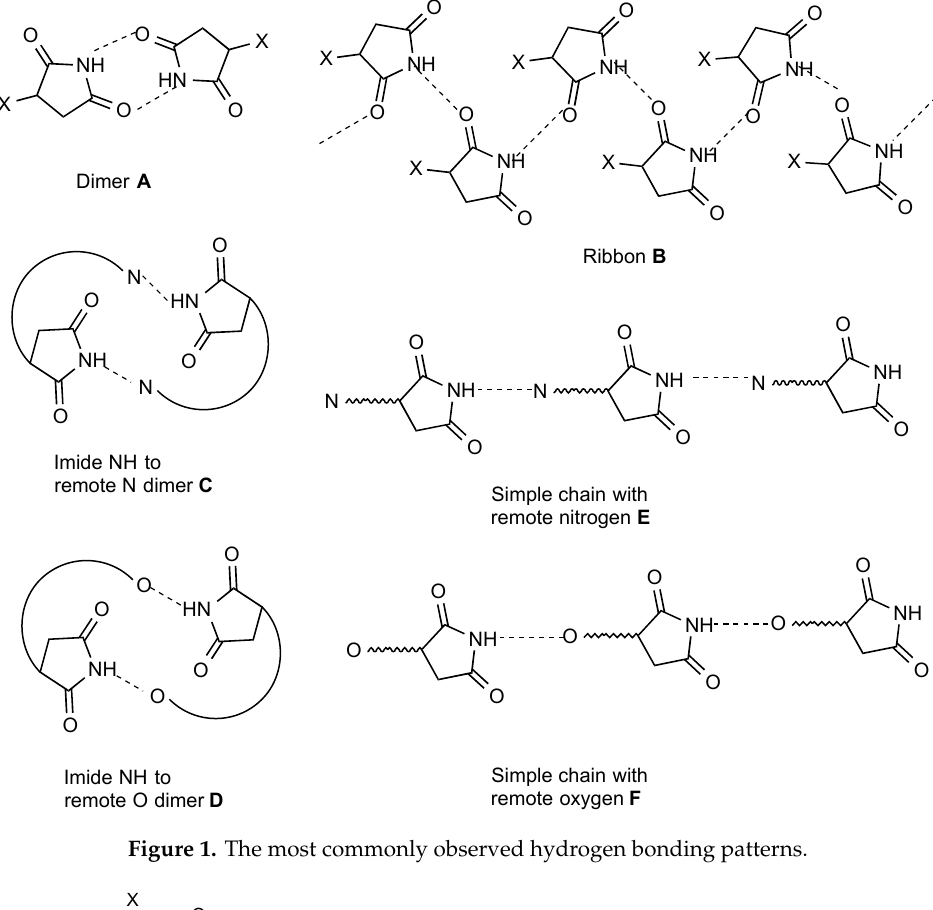
Figure 1. The most commonly observed hydrogen bonding patterns.